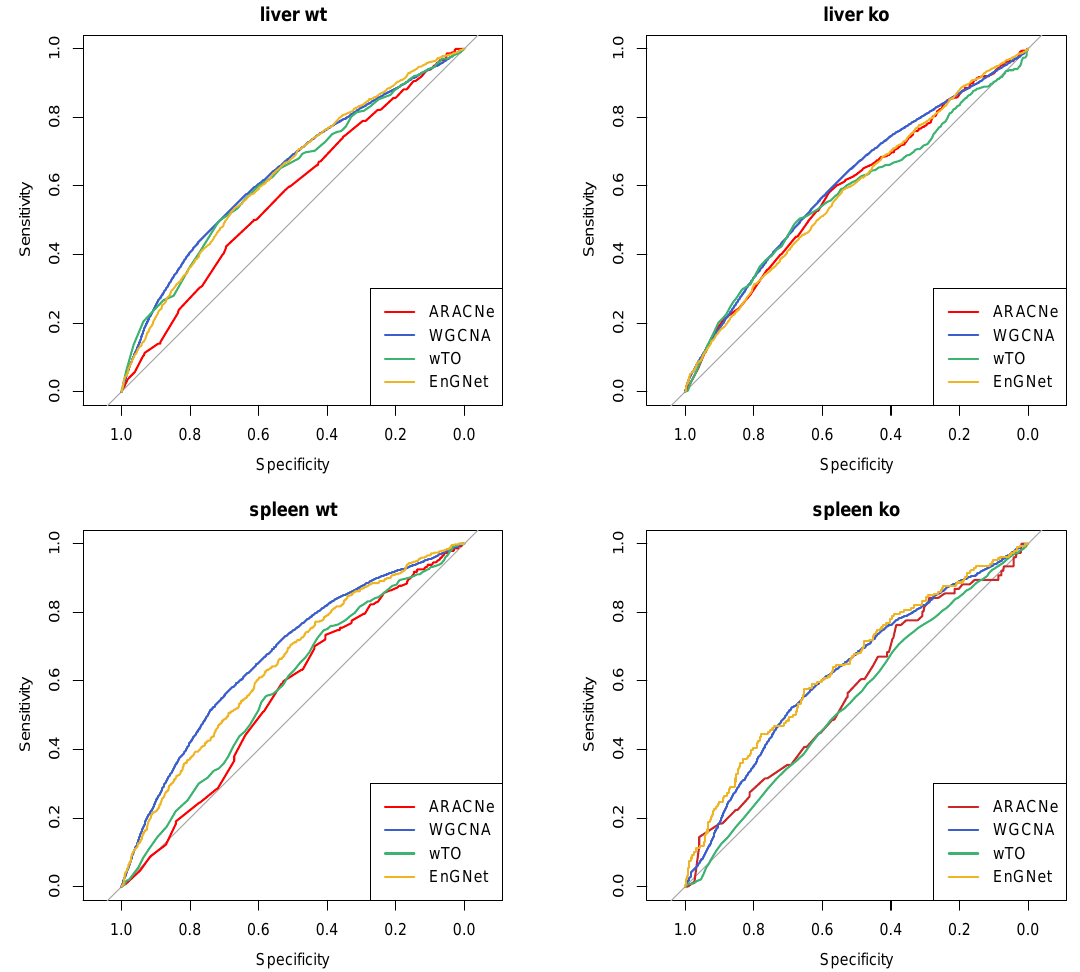
Figure A10. Receiver operating characteristic (ROC) curves for the four datasets obtained in our study using different reconstruction methods. Sensitivity is the true positive rate: TP / ( TP + FN ) . Specificity is the true negative rate: TN / ( TN + FP ) . TP, true positive; TN, true negative; FN, false negative; FP, false